Question: What form of chart is displayed?
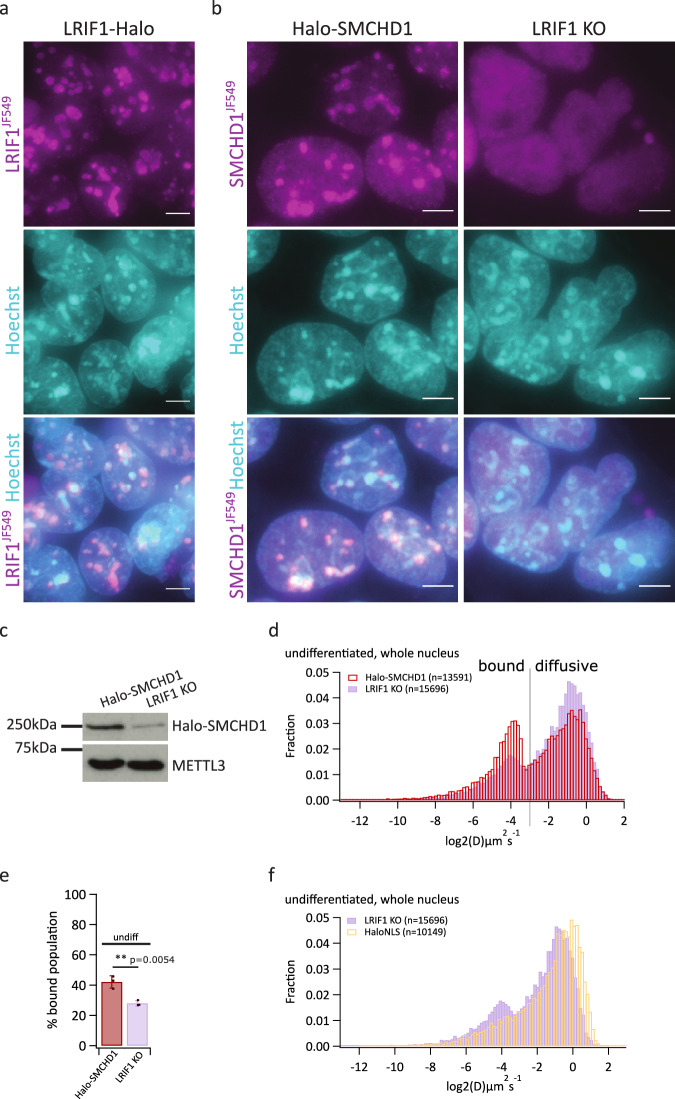
Answer: histogram